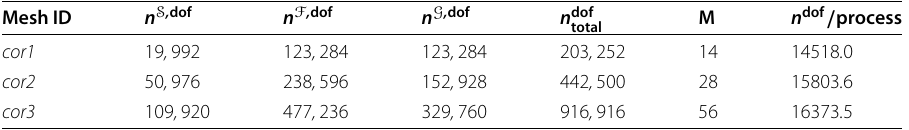
Table 5 Meshes for the Coriolis flow meter example